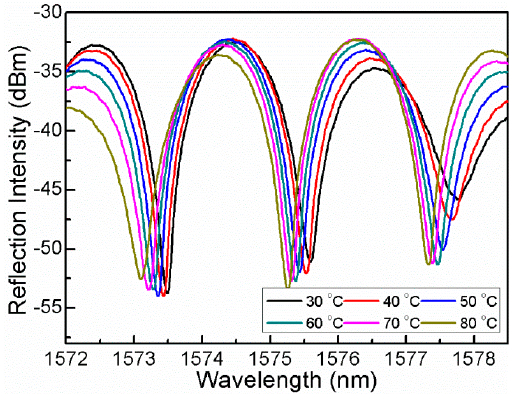
Figure 7. Interference spectral response to temperature increase from 30 °C to 80 °C.